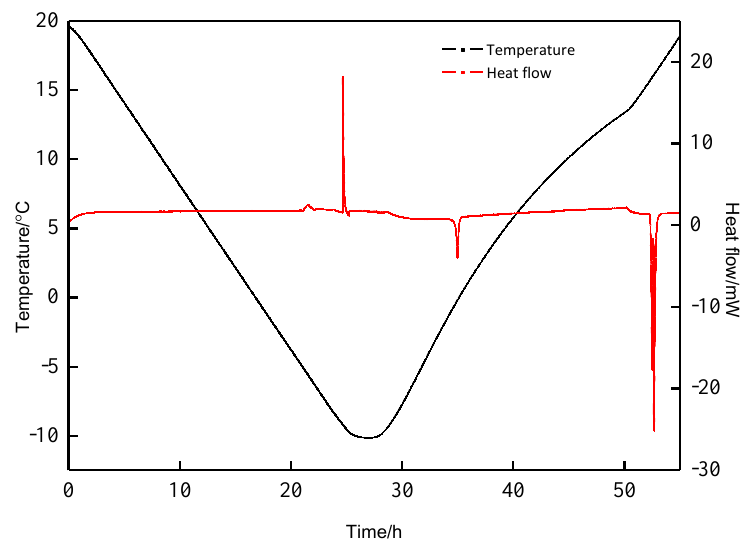
Figure 5. Heat flow and temperature curve at 20.0~−5.0 °C and 5.0 MPa.